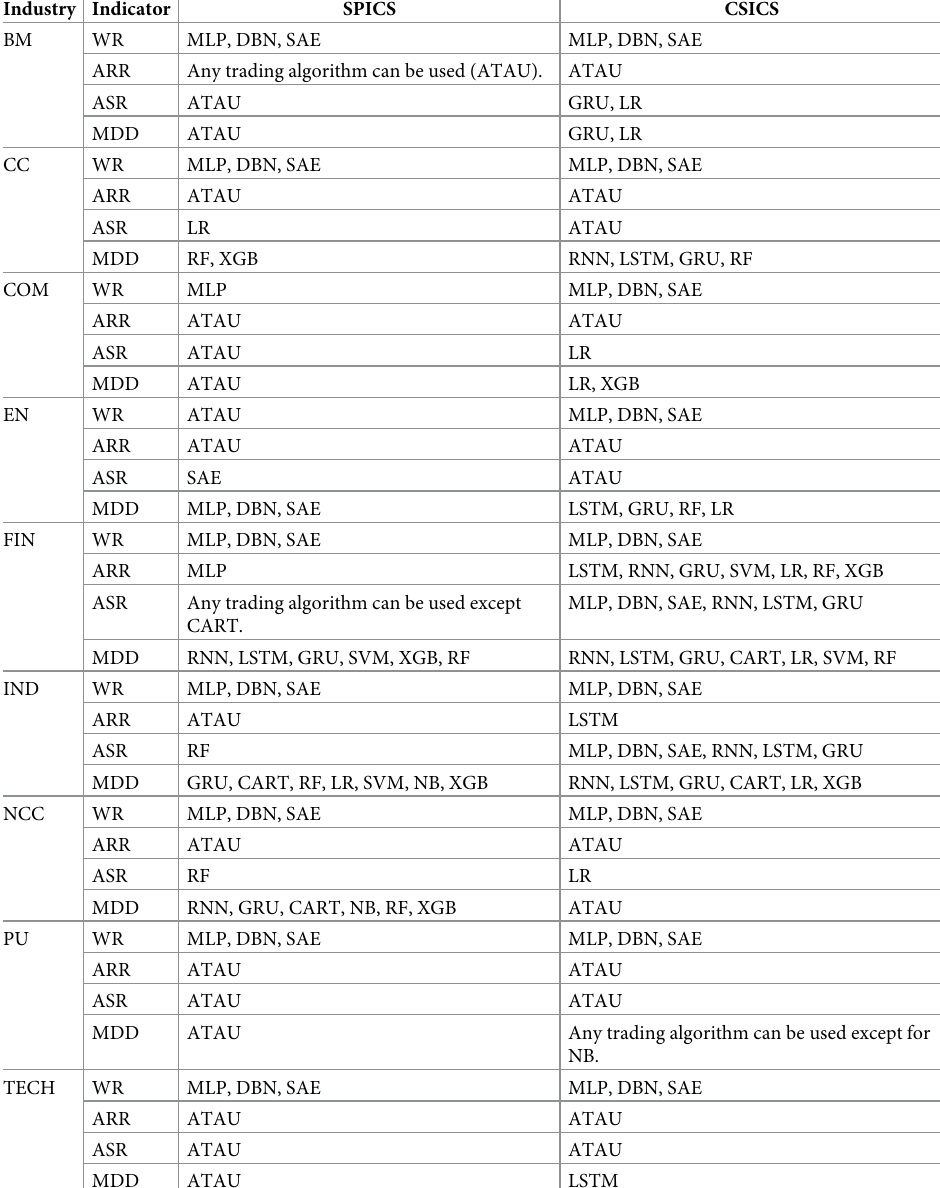
Table 12. TOTAs are selected according to a single indicator. Industry Indicator